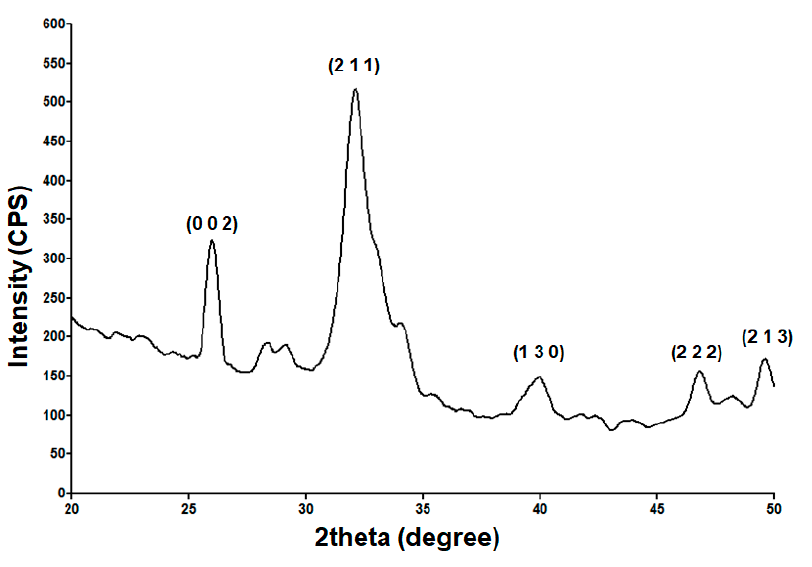
Figure 1. XRD pattern of hydroxyapatite (HAp) powder.